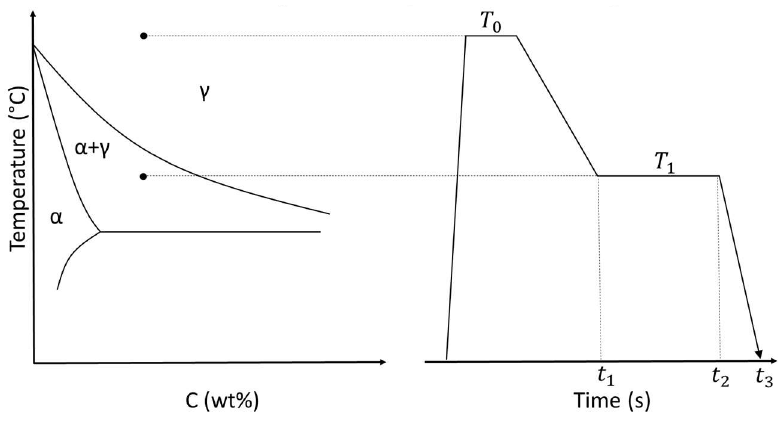
Figure 2. Schematic view of the step-quenching heat treatment process routine.